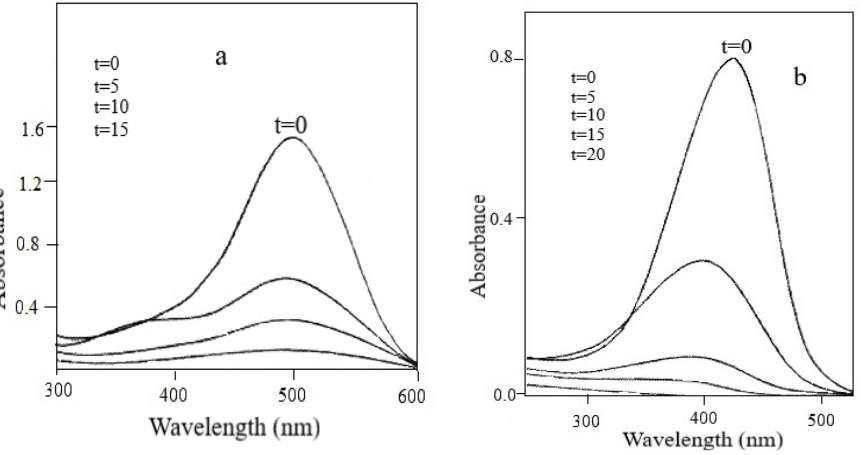
(b) for the dye systems. The completion of the dye oxidations is known from the absorbance dropping to near-zero values.